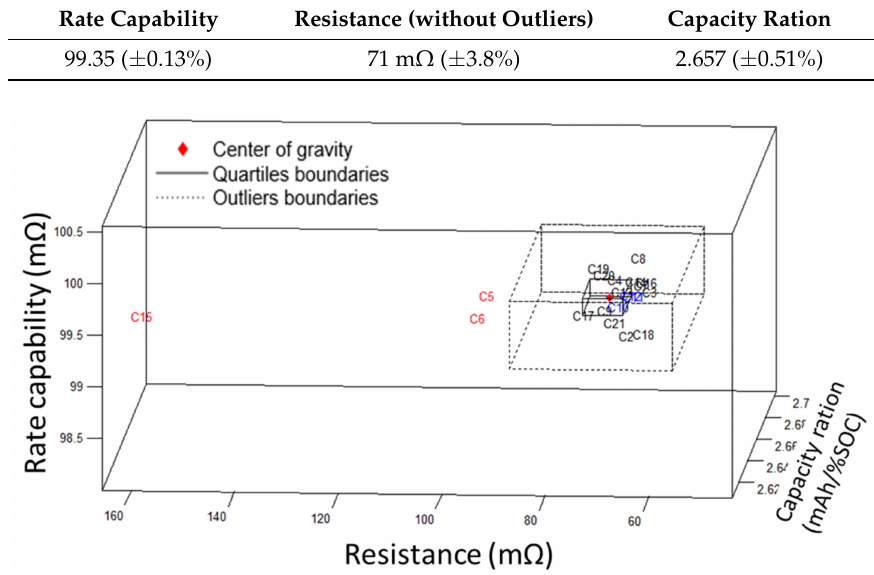
Figure 1. Cell-to-cell variations summary showing the distribution of resistance, rate capability and capacity ration on a 3D scale. Outliers were defined as any value with a deviation above 3 times the standard deviation compared to the average value. Cells 5, 6 and 15 were not used to produce 4S battery